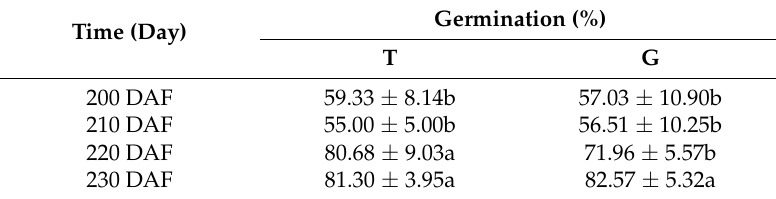
Table 3. Effects of seed-collection time on the germination of seeds from T and G.